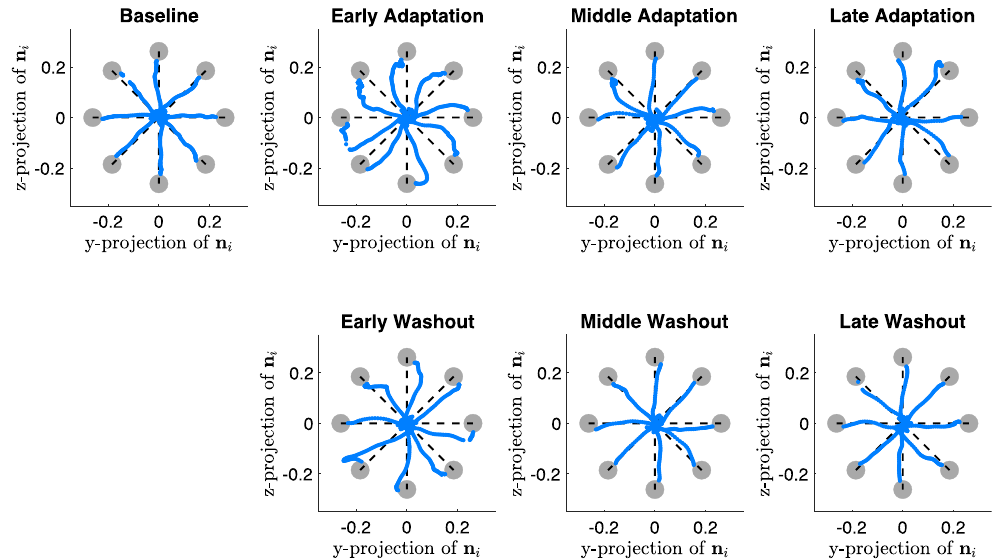
Figure 2. Pointing trajectories for a representative participant, showing baseline , adaptation (divided into early trials 1 ÷ 10, middle trials 11 ÷ 25 and late trials 26 ÷ 40) and washout (divided into early, middle and late trials). Blue dots represent movements from center to peripheral targets, while grey circles represent the targets that the participants are asked to point. Noteworthy, the trajectories depicted for the adaptation phases are rotated according to the provided visuomotor perturbation, i.e. 30 ◦ CCW rotation, in order to represent the participant perspective during the task execution.